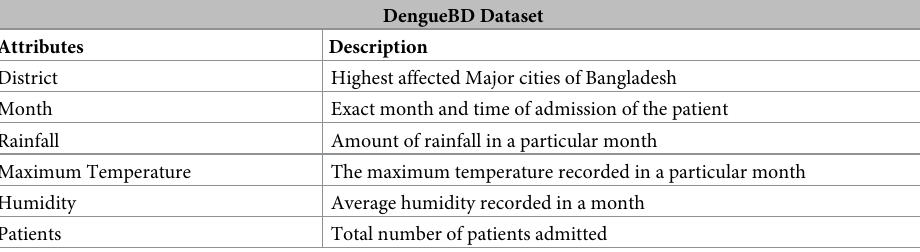
Table 1. Description of the DengueBD dataset that is created and used in this